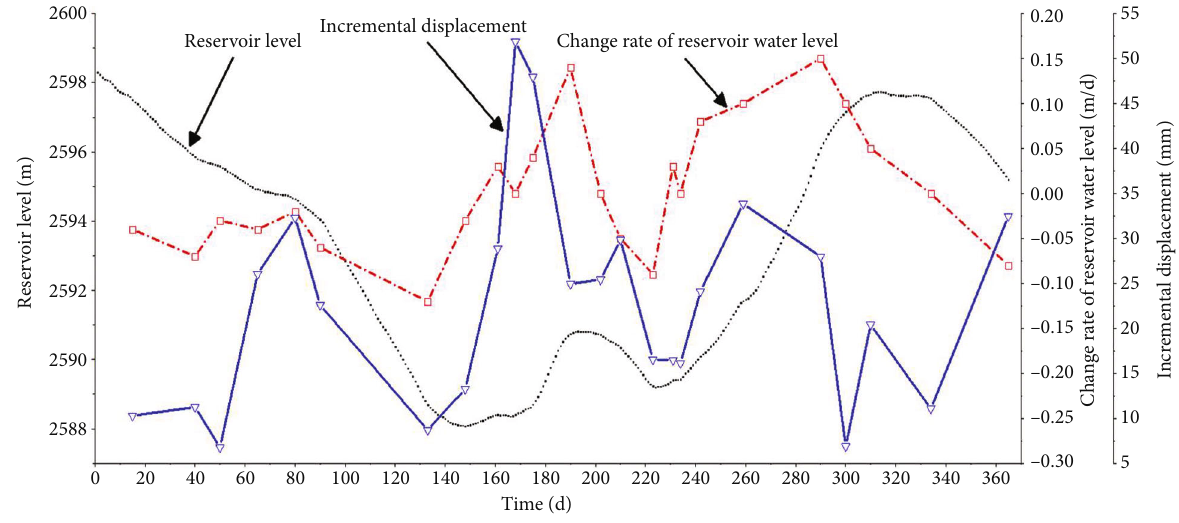
Figure 10: Incremental displacement calculation results.